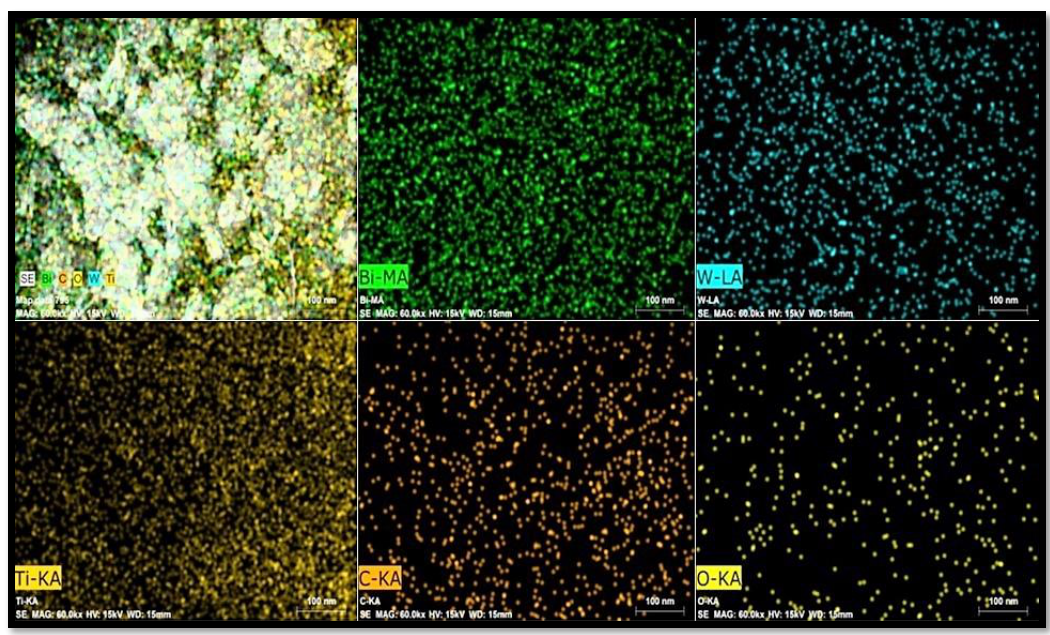
Figure 3. Elemental mapping of Bi 2 WO 6 /C-dots/TiO 2 showing different colors for Bi, W, Ti, C and O.